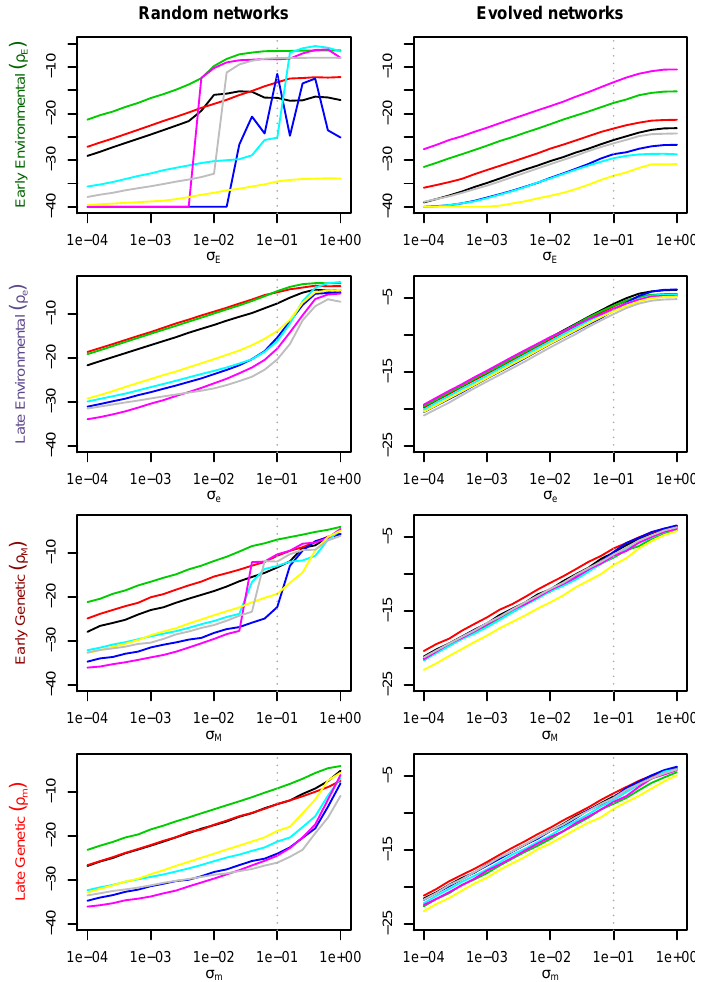
Figure SI1 – Sensitivity of the robustness measurements to the magnitude of the distur- bance. Four out of five robustness indicators ( ρ E , ρ e , ρ M , ρ m ) depend on the magnitude of the disturbance ( σ E , σ e , σ M , and σ m , respectively). The figure displays the influence of the size of the disturbance on the robustness measurement (left: 10 random networks, right: 10 evolved networks). Vertical dotted lines stand for the values used in the simulations. Robustness scores are not completely consistent for random networks, as some of them can be differentially robust to large or small disturbances. The consistency is better in evolved networks (the rank of different genotypes in terms of robustness rarely depends on the size of the